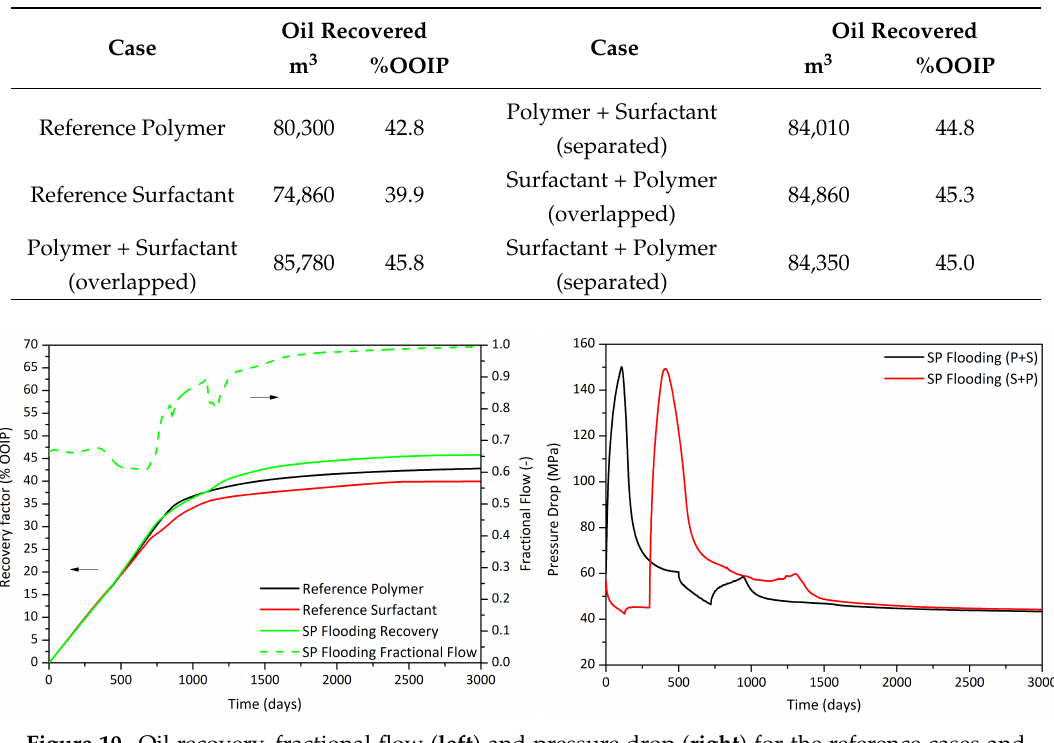
Figure 10. Oil recovery, fractional flow ( left ) and pressure drop ( right ) for the reference cases and different SP schemes, considering adsorption phenomena in a five pseudo-component